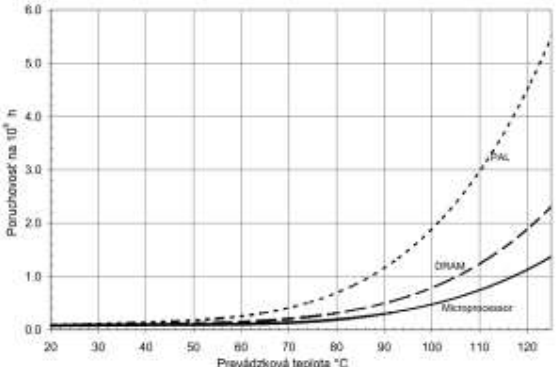
Fig. 1. Failure depending on operating temperature for PAL (Programmable Logic Array), DRAM (Dynamic RAM), and Microprocessors, [1].